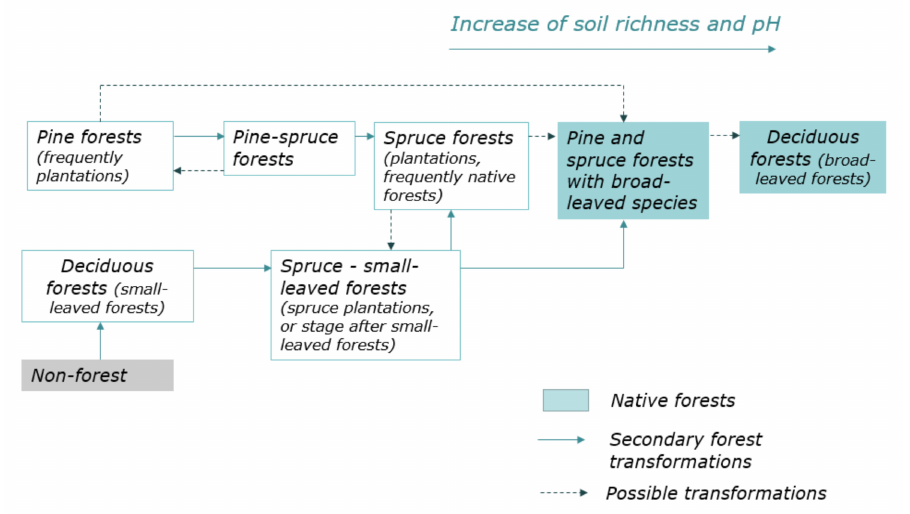
Figure 8. The DM of the coniferous